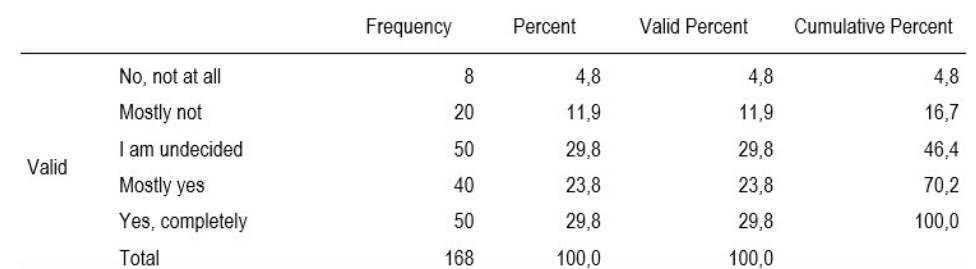
Break and inability to attend preschool can have a negative effect on children’s emotional